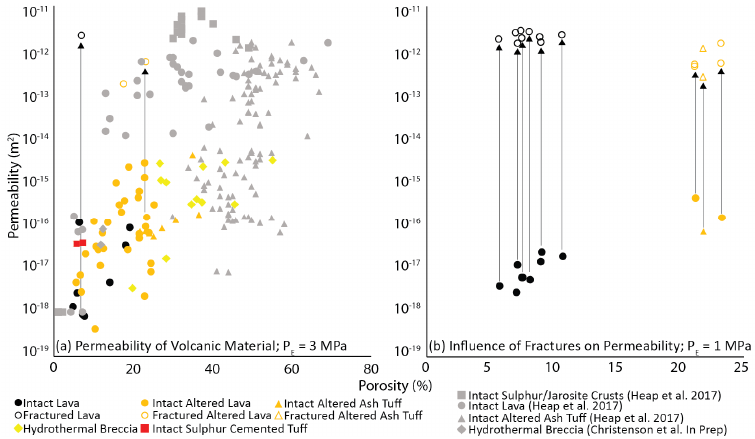
Figure 6. Permeability as a function of porosity at ( a ) confining pressure 3 MPa (this study) and 1 MPa, and ( b ) confining pressure 1 MPa showing the wide variability of matrix permeability (solid black points are unaltered intact lava from the edifice; yellow are altered intact ballistic samples collected at 3 MPa confining pressure) and low variability of fracture permeability (open points).